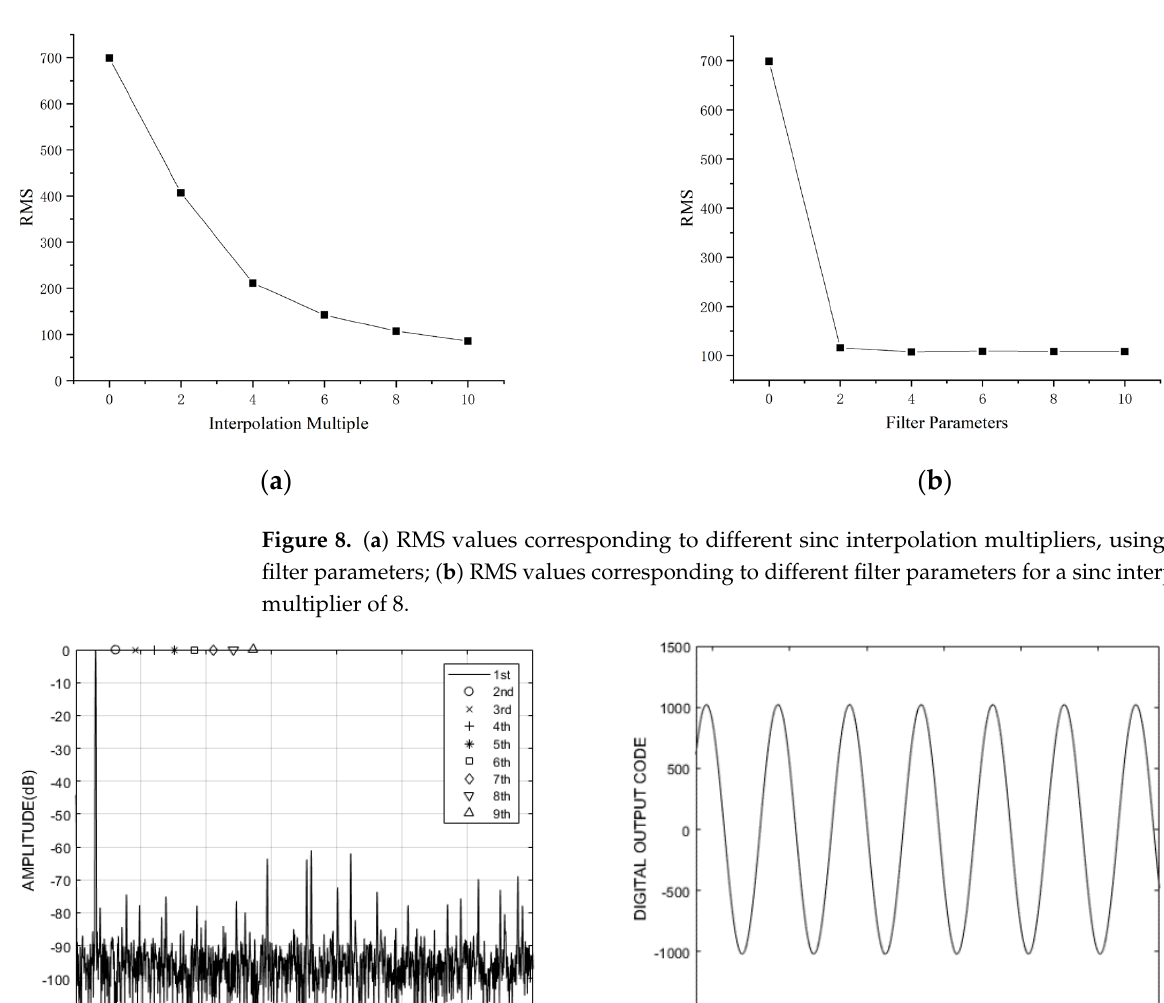
Figure 8. ( a ) RMS values corresponding to different sinc interpolation multipliers, using default filter parameters; ( b ) RMS values corresponding to different filter parameters for a sinc interpolation multiplier of 8.